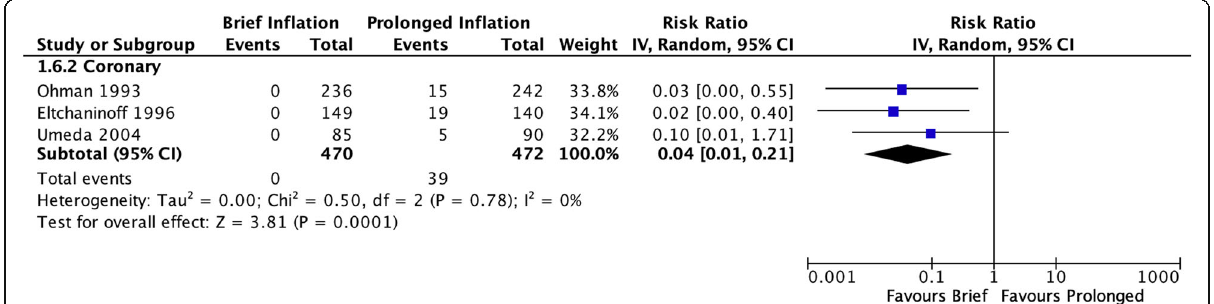
Fig. 5 Risk of patient inability to tolerate initial duration of balloon inflation due to end-organ